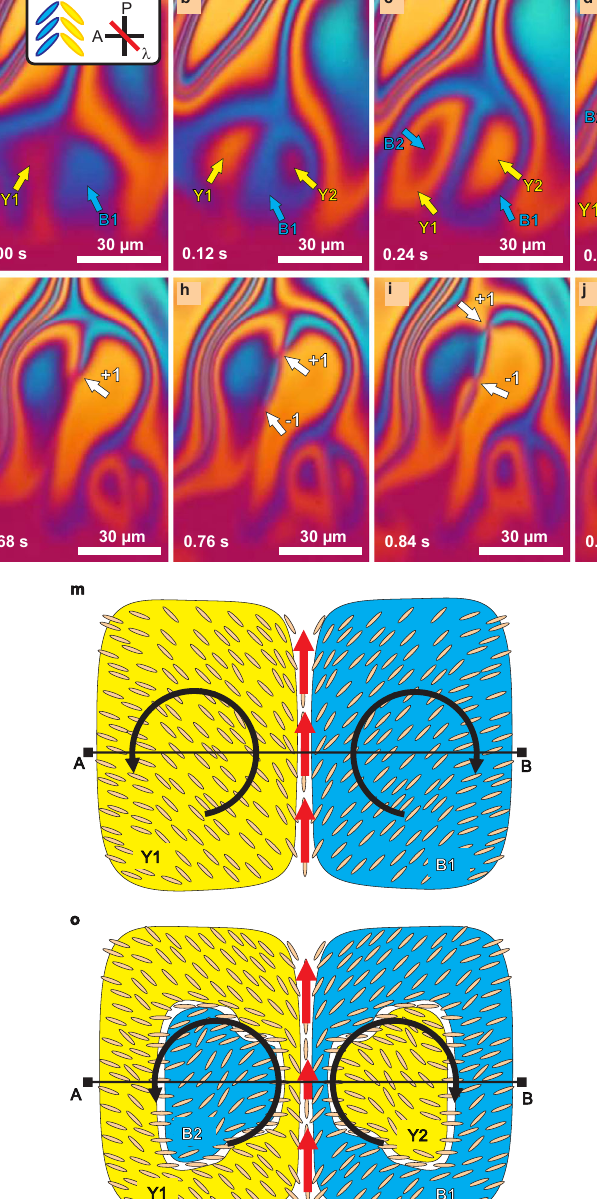
untilthey fi nallyannihilate.Panels( a – l )aresnapshotsfromavideoofEvent1shown in Supplementary Movie 5. m – p Schematic view of defect formation shows the proposed director con fi guration while the defects are being created. m At the boring bandsofY1 and B1become thinner. p The thinstripes breakand secondary regions B2 and Y2 become neighbors and topological defects are